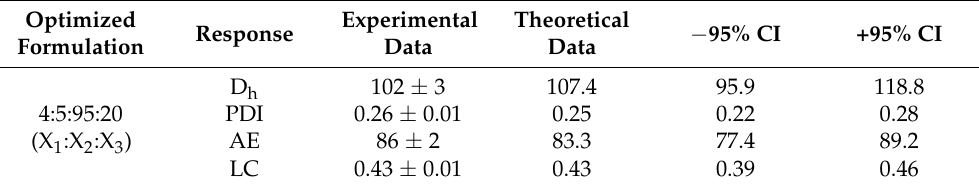
Table 3. Optimum levels of the selected factors to prepare the optimized formulation and experimen- tal ( n = 3, mean ± SD) and theoretical values obtained for the selected responses. The 95% confidence interval (CI) obtained from the theoretical data is also